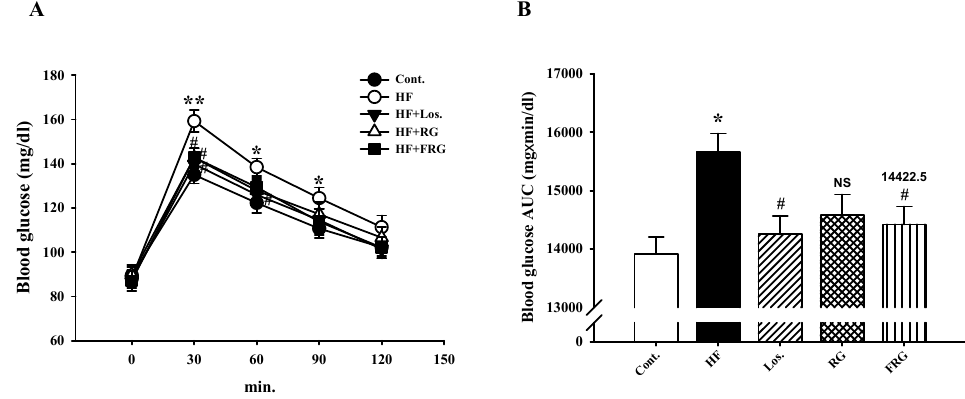
Figure 2. Effect of an FRG on oral glucose tolerance tests ( A ) and the blood glucose area under curve (AUC) ( B ). Values were expressed as mean ± S.E. ( n = 10). * p < 0.05, ** p < 0.01 versus Cont.; # p < 0.05 versus HF. Abbreviations: HF, high fructose; HF + Los., high fructose diet with losartan; HF + RG, high fructose diet with red ginseng; HF + FRG, high fructose diet with fermented red ginseng.